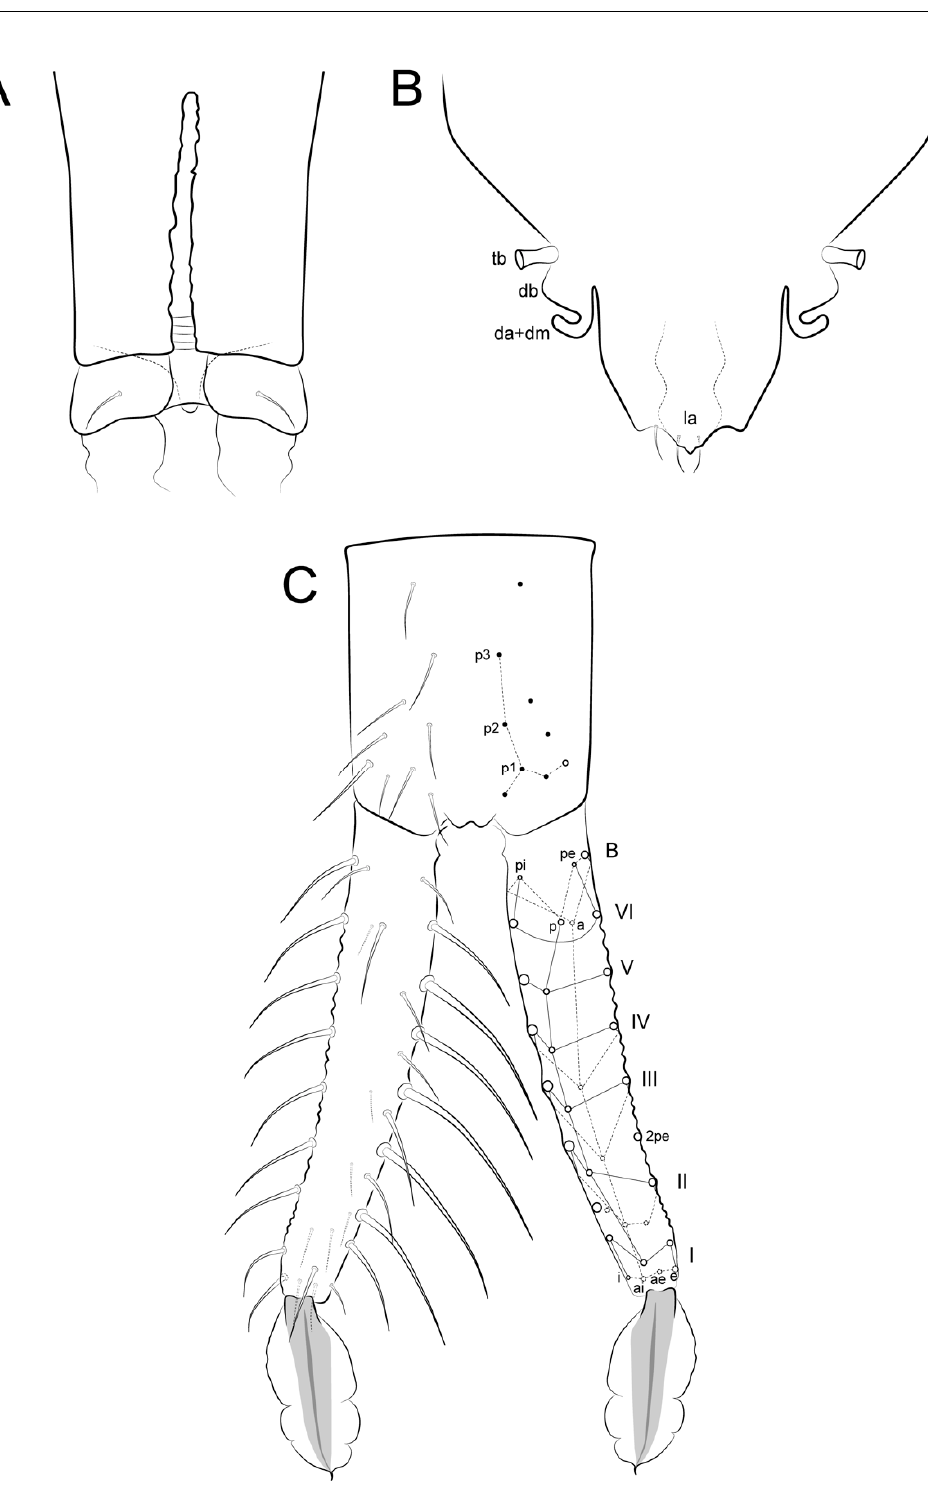
Figure 17. Arlesminthurus caatinguensis sp. nov. male’s abdominal appendages: ( A ) collophore (anterior view); ( B ) tenaculum (anterior view); ( C ) furcula (dorsal view); the left side is presented as observed and on the right side is a schematic representation.